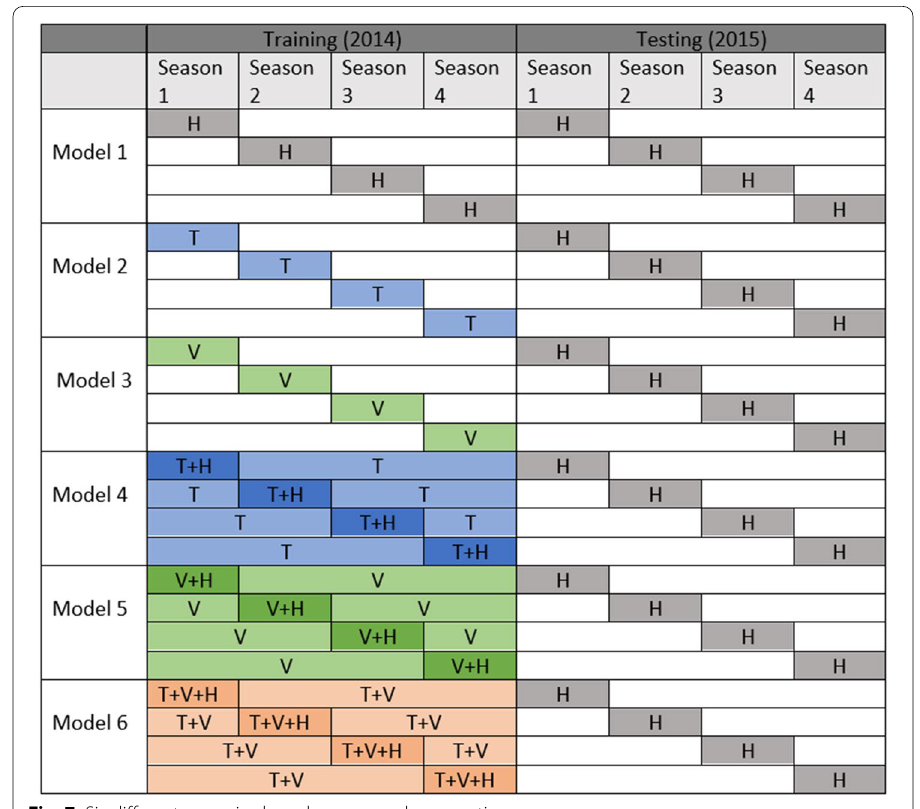
Fig. 7 Six different scenarios based on seasonal